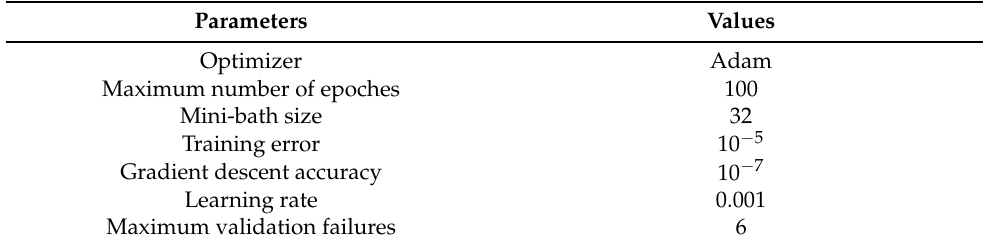
Table 5. Parameters for training deep learning